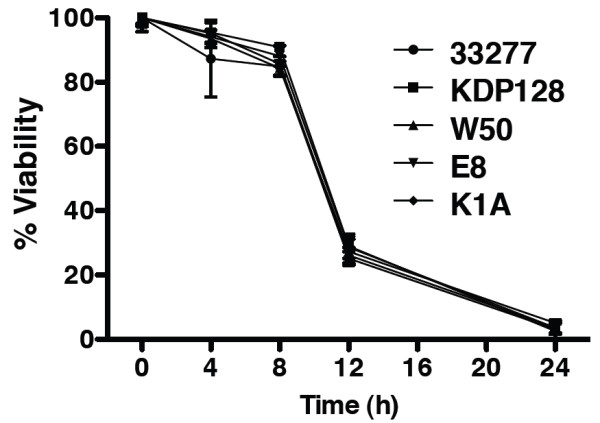
Bacterial viability was determined following epithelial cell challenges. From each challenge assay reported in Fig. 4, supernatant containing bacteria was removed at 4, 8, 12, and 24 hours, plated in blood agar plates and colony forming units were counted. P. gingivalis strains cultured were 33277, KDP128, W50, E8 and K1A. For all strains > 80% viability persisted until 8 h, where upon viability decreased to approximately 30% at 12 h and 1–2% at 24 h. Values represent the means ± SD of at least two experiments.